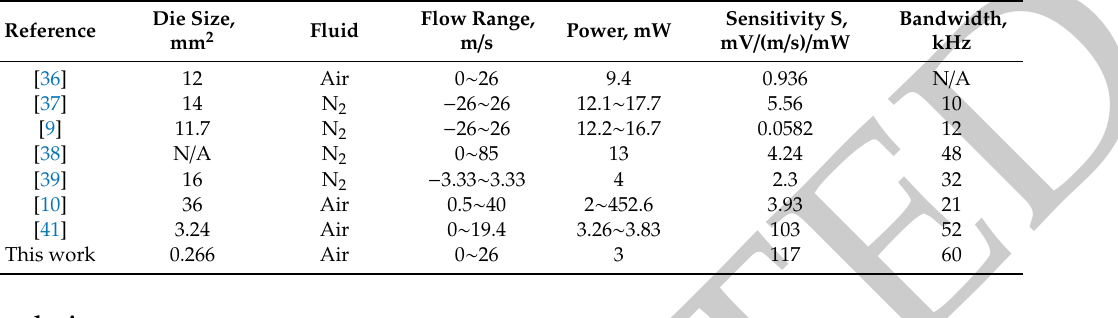
Table 2. Comparison between the reported calorimetric flow sensor and current